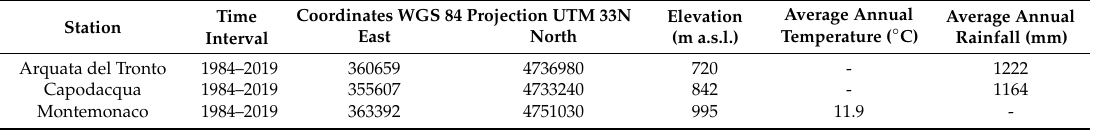
Table 1. Average annual temperature and rainfall stations